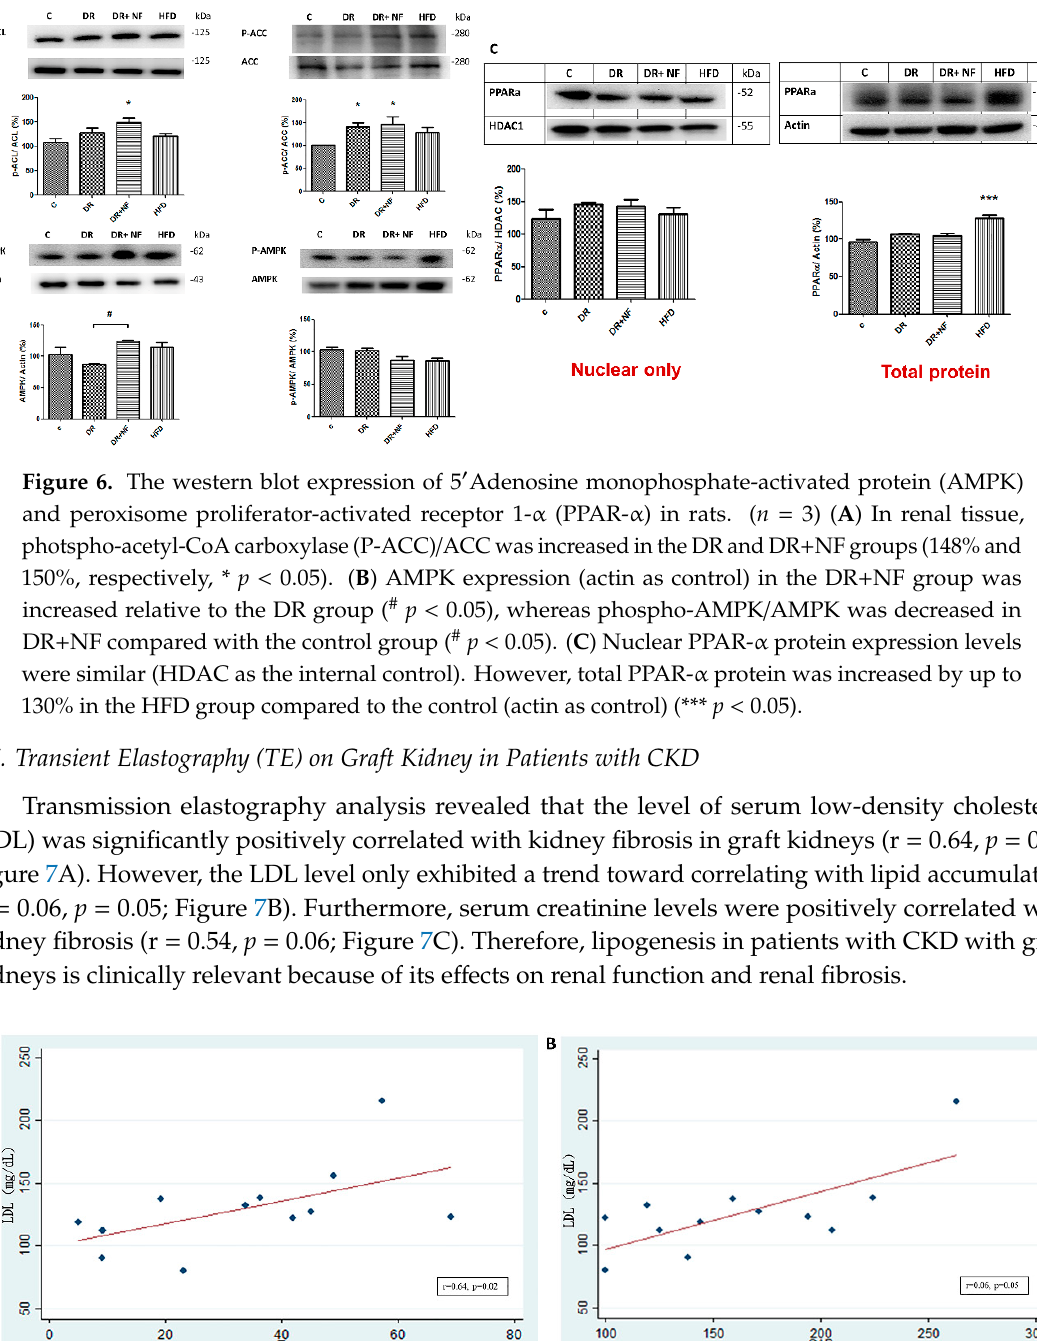
Figure 7. Low-density lipoprotein (LDL) levels and graft kidney lipid accumulation/fibrosis in 211